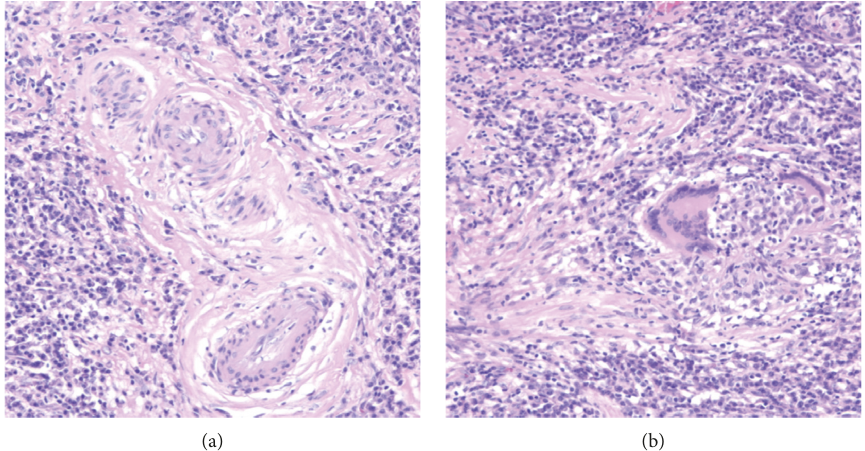
Figure 3: Histopathological examination of the granulomatous mucosa from the ethmoid sinus shows significant necrotizing vasculitis (a) and granulomatous inflammation with multinucleated giant cells (b) (HE staining, × 200). MT: middle turbinate.